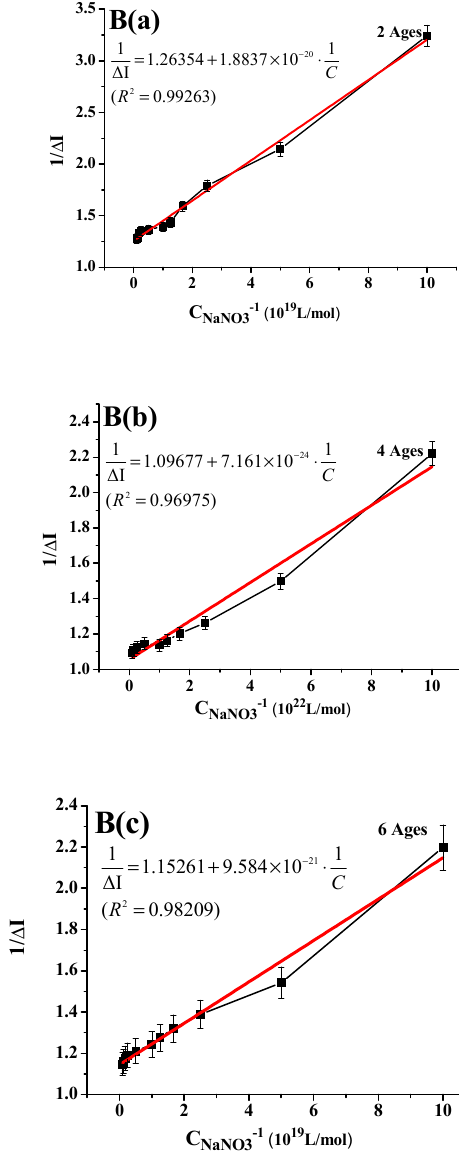
Figure 3. Linear relationship between the response current and the concentration of sodium nitrate: ( A ) Determination of the correlation curve between the response current of the root meristem sensors of two-, four-, and six-year-old ginseng plants and the concentration of sodium nitrate; ( B ) Double reciprocal regression curves of the root-meristem sensors of two-, four-, and six-year-old ginseng plants in sensing a sodium nitrate